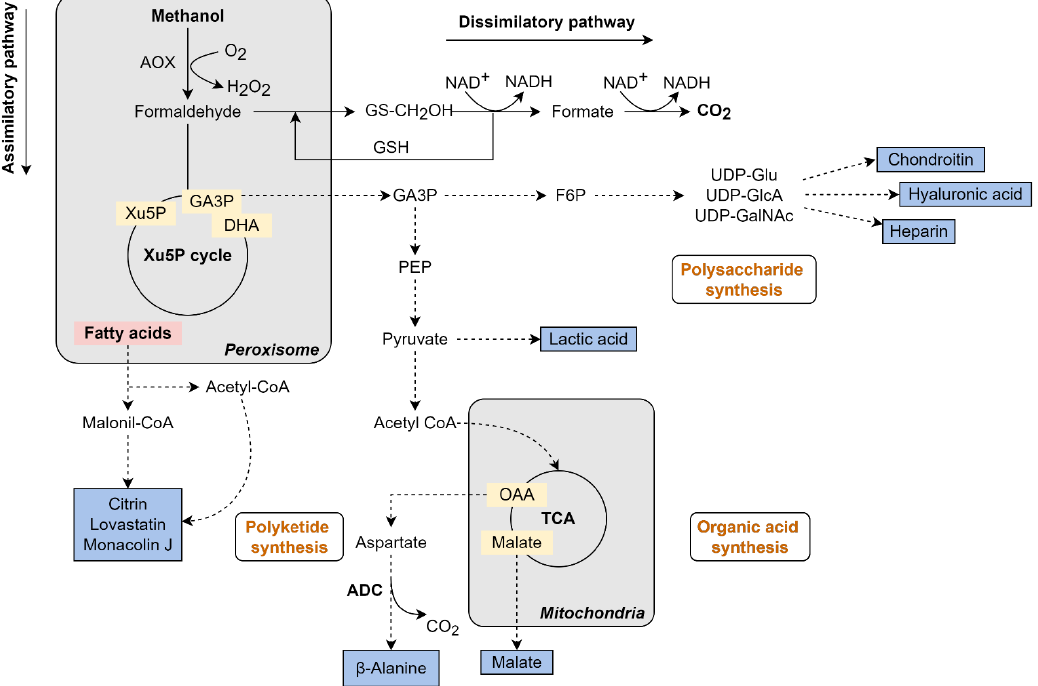
Figure 5. Metabolic pathways that led to methanol assimilation and production of a variety of chem- icals by K. phaffii. Black arrows represent the native methanol metabolism, dotted arrows represent an overexpressed/heterologous pathway. Bold enzyme names represent an overexpressed/heterol- ogous enzyme, and the blue boxes represents the product formation. Some reactions are summa- rized for better comprehension, also, not all cofactors are represented in the figure. AOX: Alcohol oxidase; Xu5P: Xylulose-5-phosphate; DHA: Dihydroxyacetone; GAP: Glyceraldehyde-3-phos- phate; XuMP: Xylulose-monophosphate cycle; PEP: Phosphoenol pyruvate; F6P: Fructose-6-phos- phate; OAA: Oxalacetate; ADC: L-aspartate decarboxylase. The figure of own authorship is based on KEGG pathways (www.genome.jp — accessed on 13 September 2022) and in the literature cited in the text.